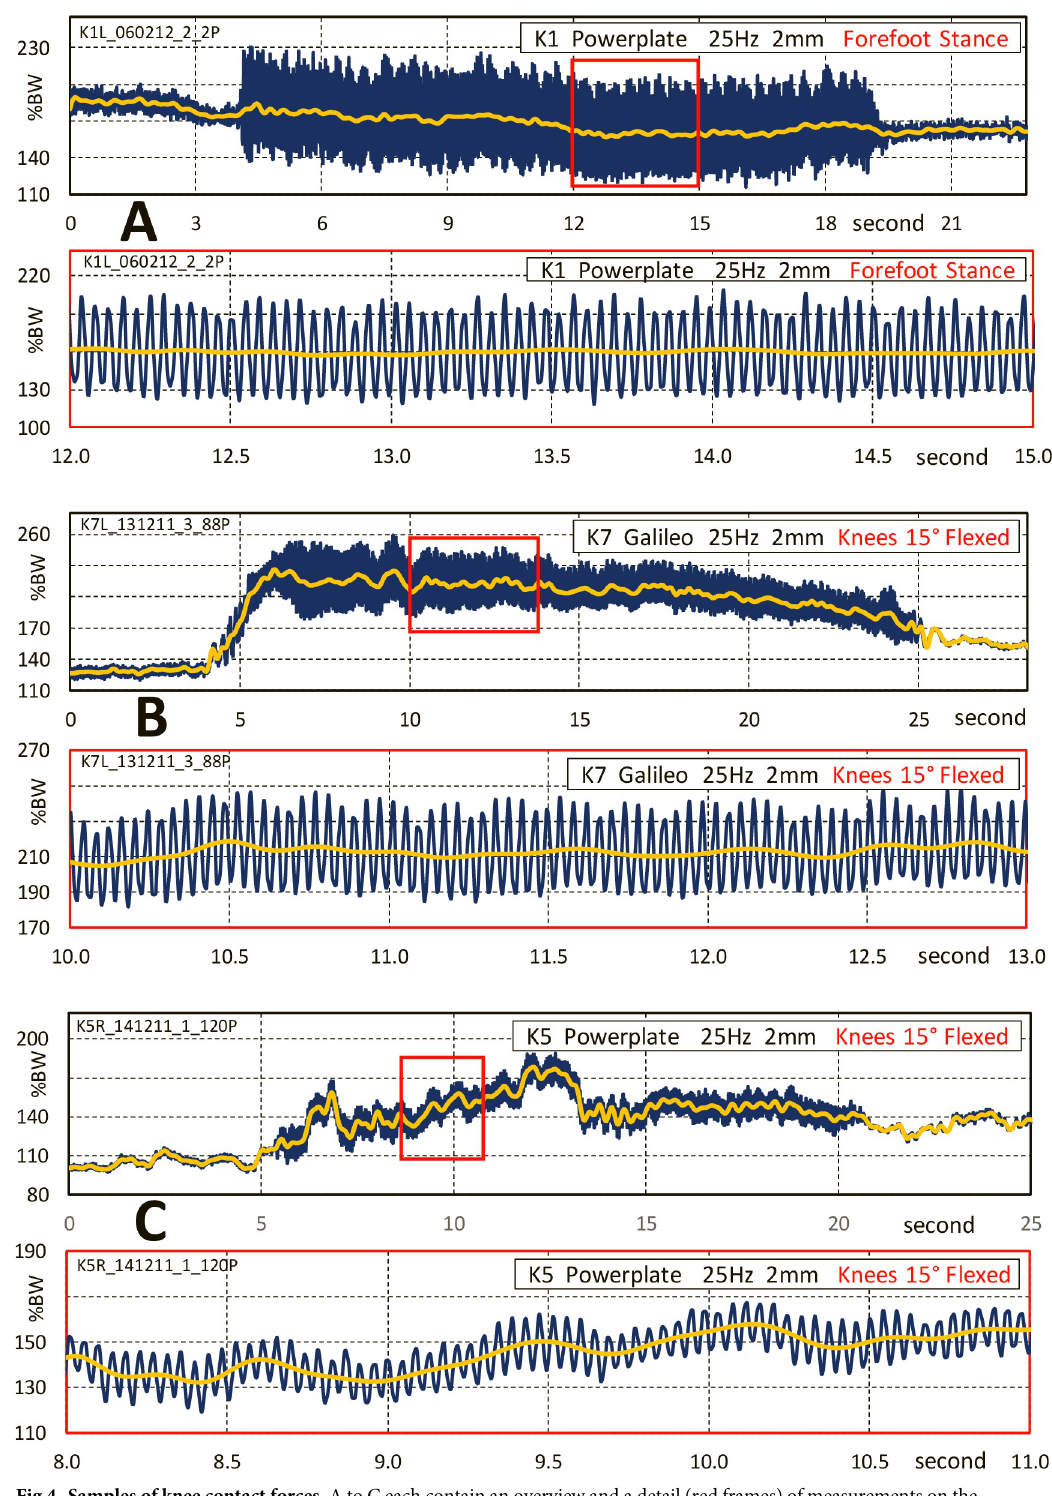
Fig 4. Samples of knee contact forces. A to C each contain an overview and a detail (red frames) of measurements on the Powerplate or Galileo at 25 Hz, 2 mm. Blue = contact force F. Yellow = offset force F off . Vibration force F vib = difference between blue extrema and yellow curves. Note that the scales differ and don’t start at